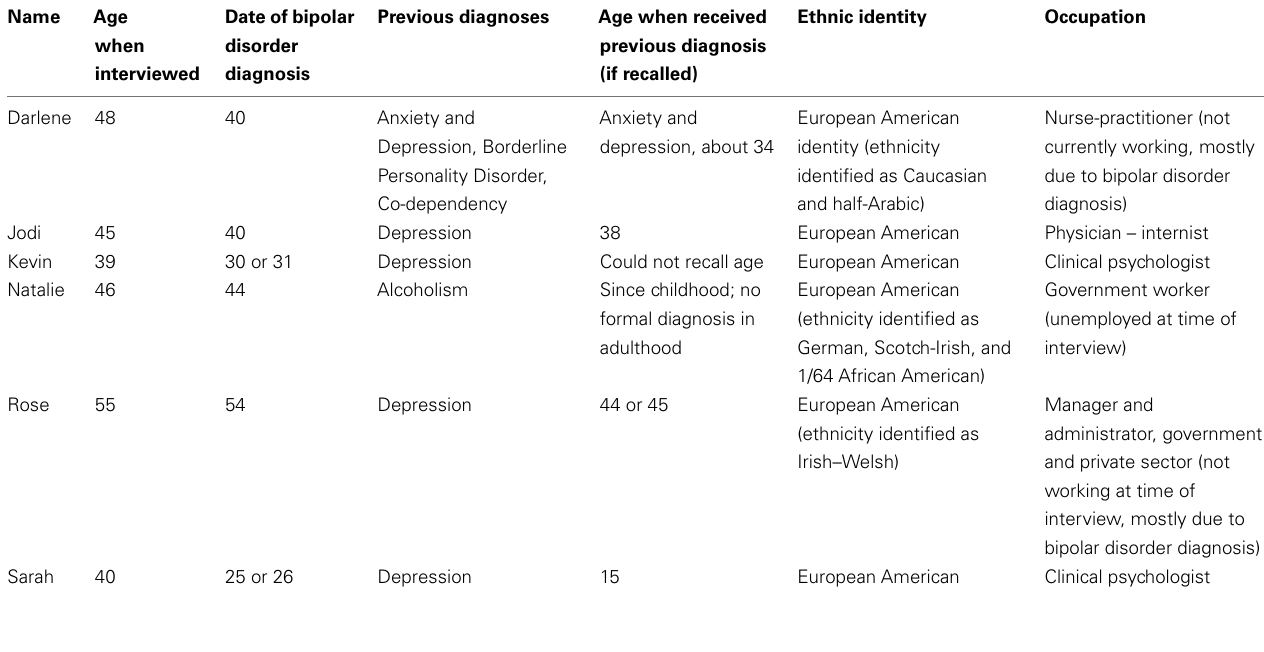
Table 1 | Basic demographic information about